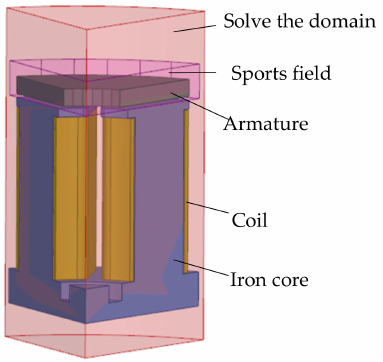
Figure 11. Electromagnet model.